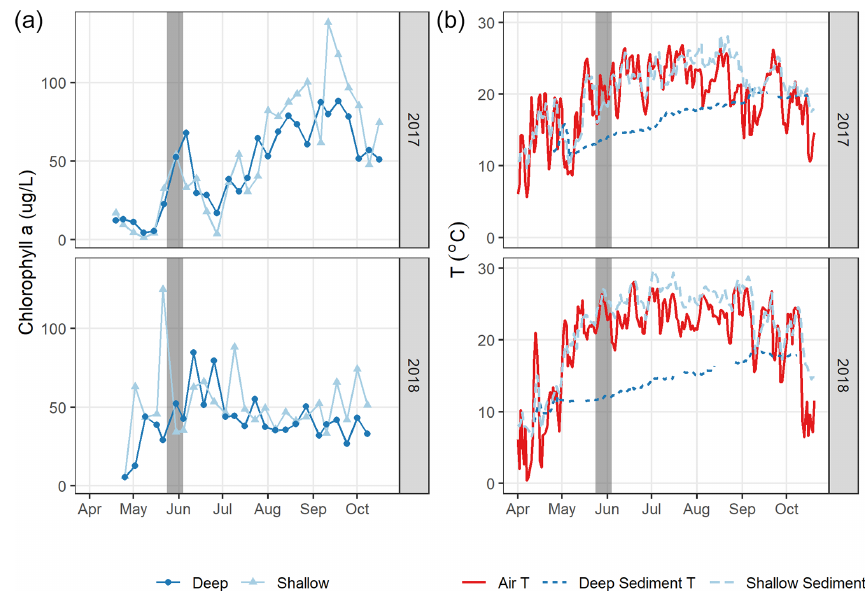
Figure 7. Daily air and sediment temperature ( a , left) and chlorophyll a (an indicator for algal biomass, b , right) in 2017 and 2018. The grey bar indicates the spring burst period of elevated F CH in 2018, likely supported by elevated sediment temperature and algal biomass levels 4 that year. Table 2. Dissolved nutrient and carbon data for the inflow and outflow during the study period, reported as the mean of weekly samples taken between April and October and as the value measured for the week of the 2018 spring burst (24 May–4 June). Dissolved nutrient data include total nitrogen (TN), ammonium (NH 4 ), nitrate (NO 3 ), total phosphorus (TP), and soluble reactive phosphorus (SRP). Dissolved carbon was measured as particulate organic carbon